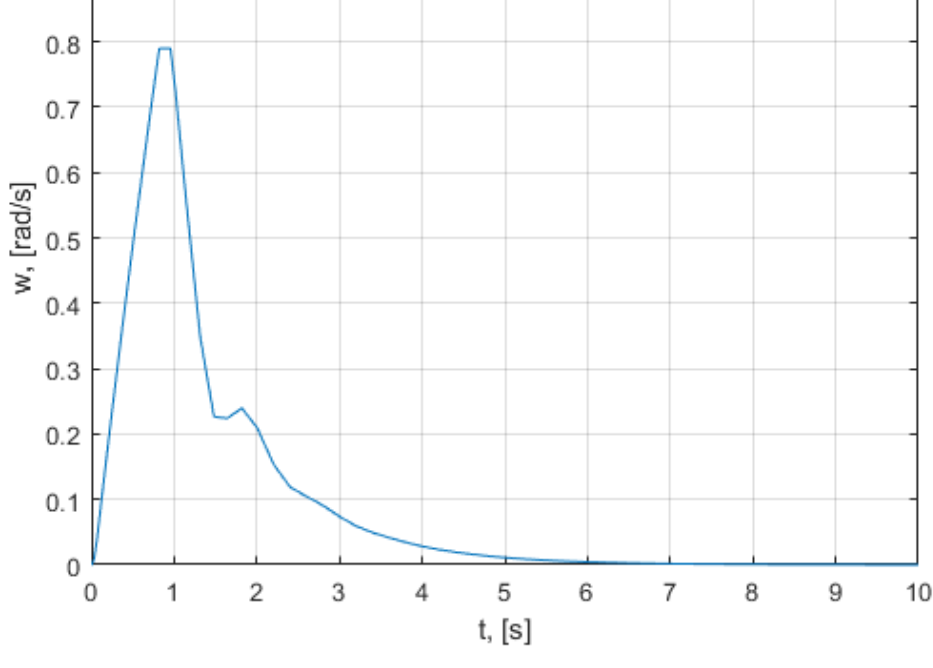
Figure A12. Speed. Figure A12. Speed.